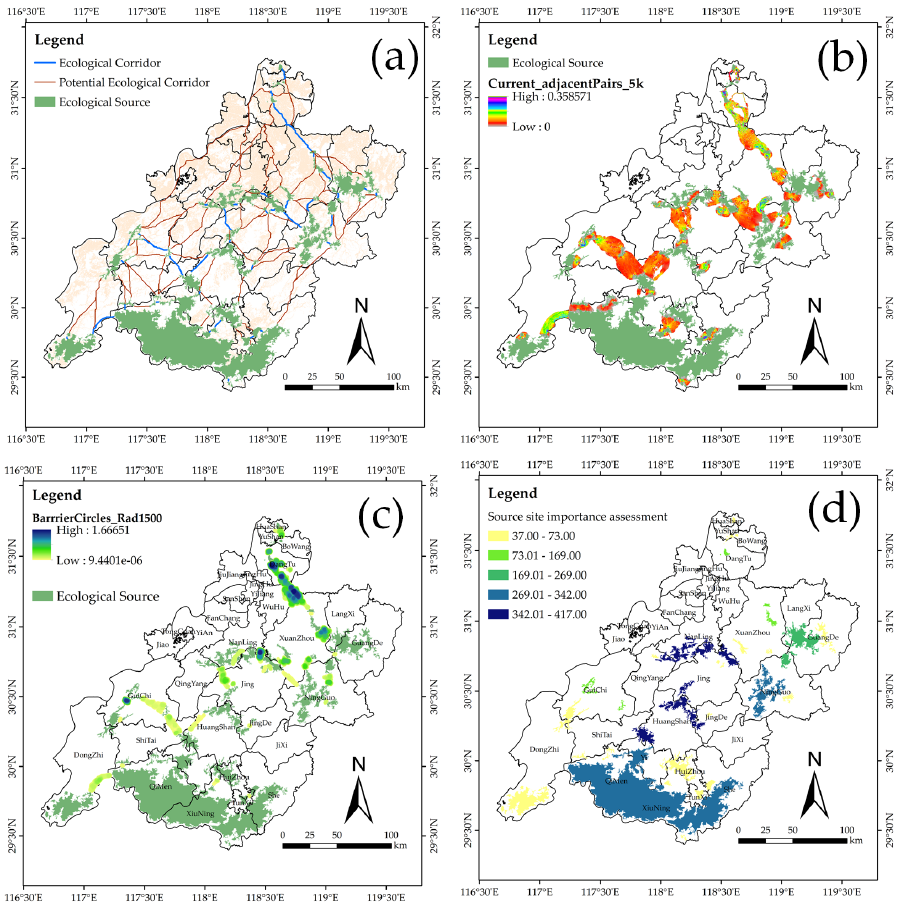
Figure 8. Distribution of ecological corridors in southern Anhui; ( a ) shows the spatial distribution of ecological sources and corridors; ( b ) is the current value of the pinch point; ( c ) is the current value of the obstacle point; ( d ) is the centrality score of the ecological source.